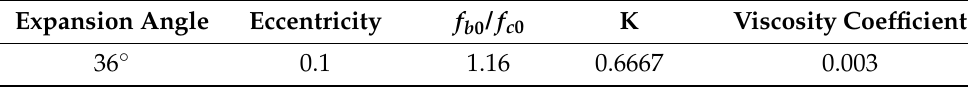
Table 2. UHPC Plastic failure criterion